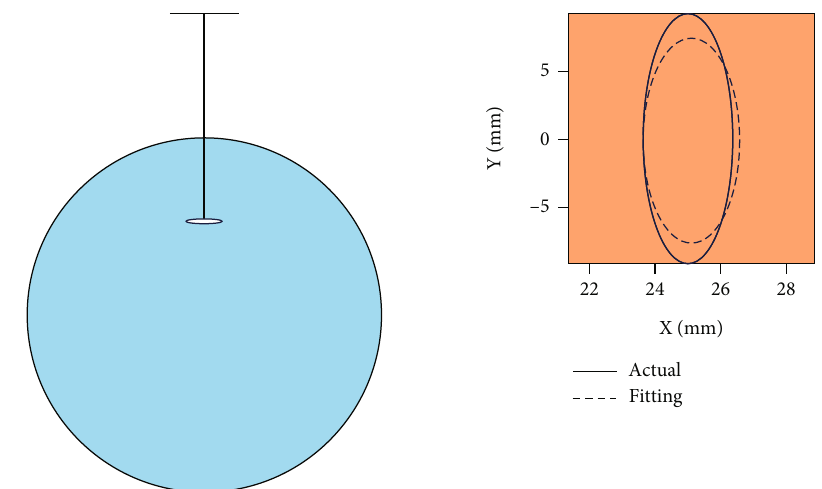
Figure 5: Schematic diagram of elliptical defect.